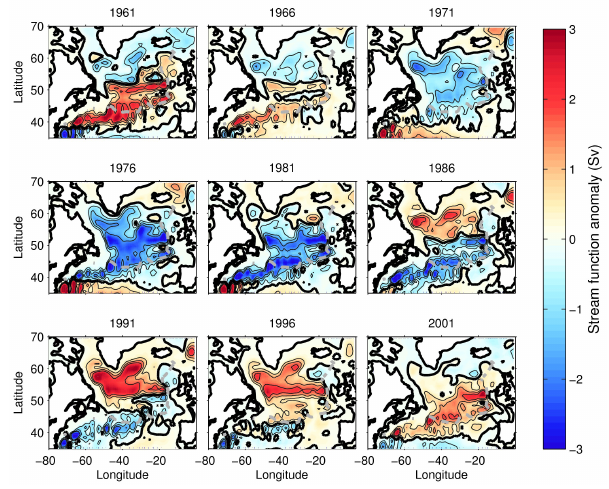
Figure 6. As Fig. 3, but for barotropic stream function anomalies (Sv). Positive anomalies (red) are cyclonic and negative anomalies (blue) are anticyclonic.